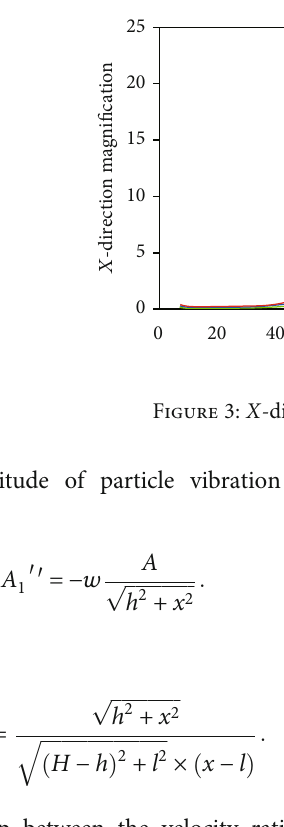
Figure 4: Z -direction particle vibration speed magni fi